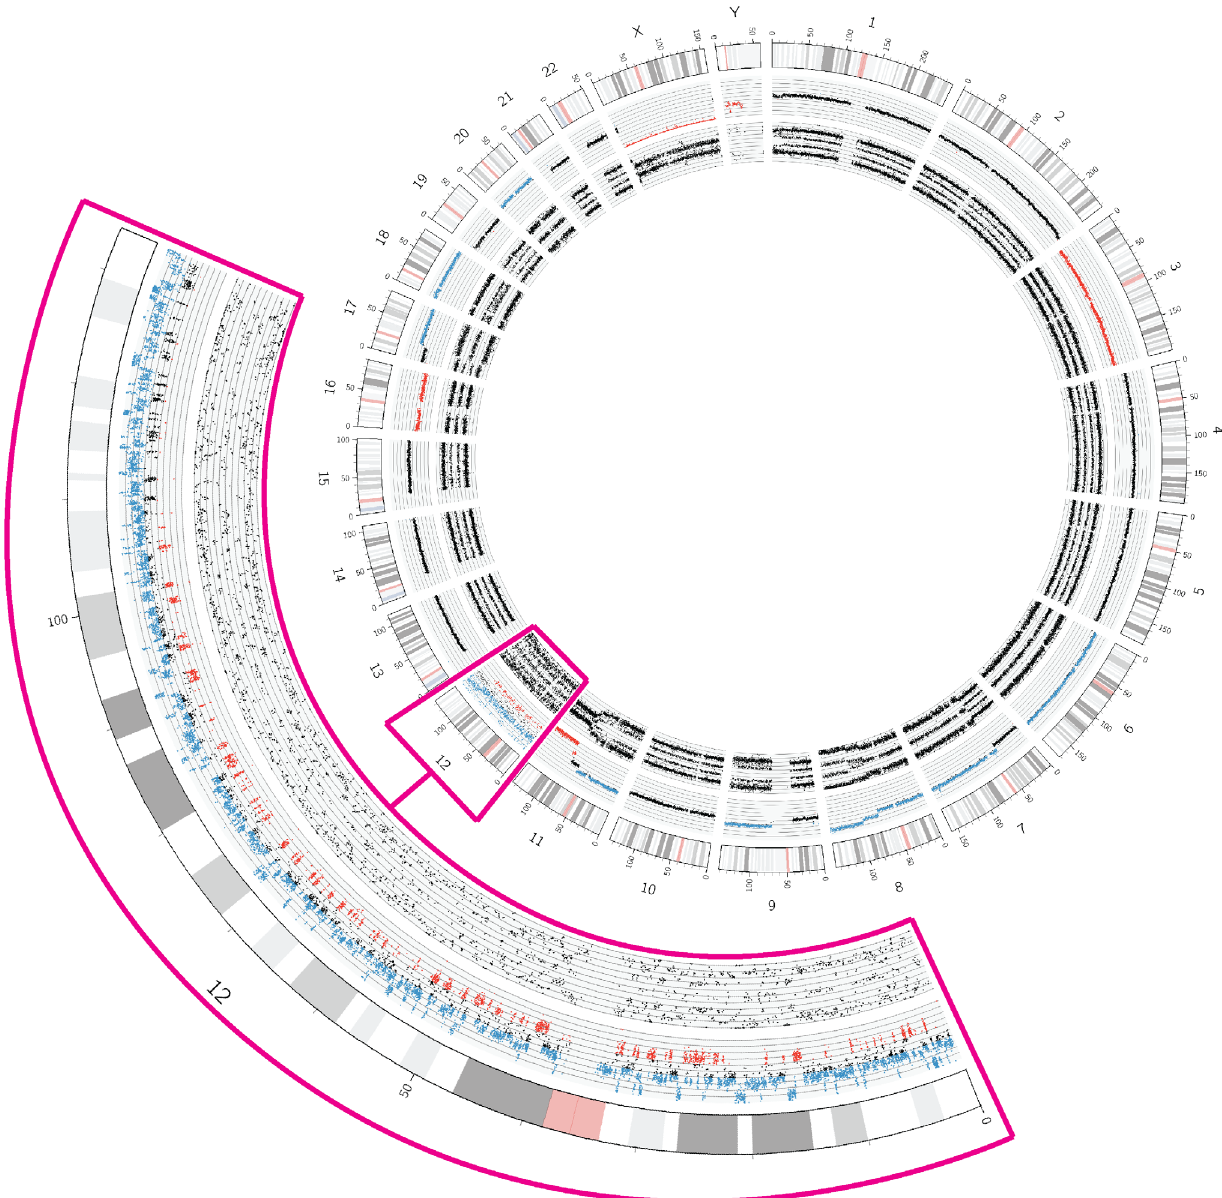
Fig 4. Circos plot of sample NB19 demonstrating chromothripsis. The tracks are from outside inwards: chromosome numbers, chromosomal positions in Mb, copy number and allele patterns, respectively. Copy number gains and losses are colored blue and red, respectively. The enlarged segment marked in pink shows a highly rearranged chromosome 12 with more than 200 breakpoints indicating chromothripsis. Additionally, a gain of the distal part of the q-arm of chromosome 12 is present. SCAs were identified on chromosomes 1, 2, (both SCAs only in a subpopulation of cells) 7, 8, 9, 11 (three SCAs) and